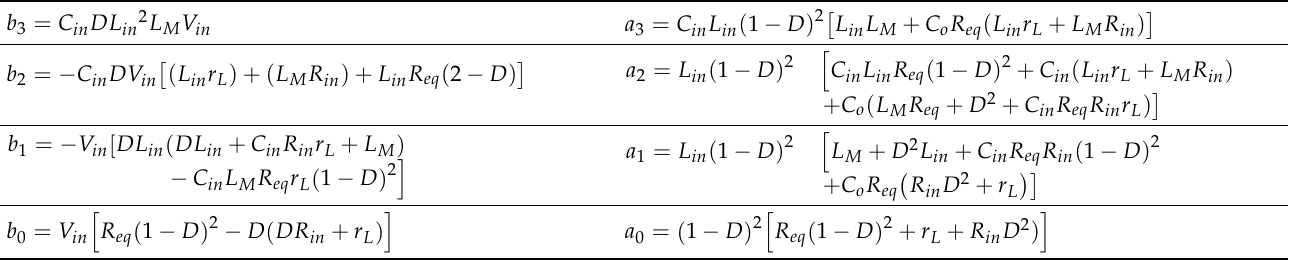
Table 4. Transfer Function